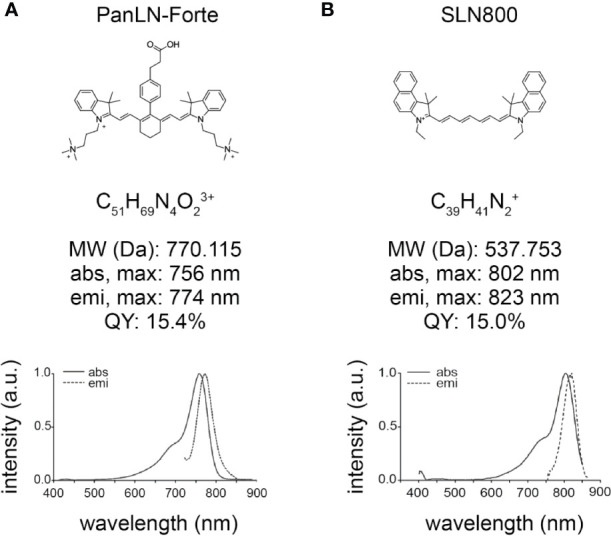
Chemical structure and optical properties of 800 nm lymph node fluorophores in HEPES-buffered serum, pH 7.4. (A) PanLN-Forte and (B) SLN800. abs, absorption; a.u., arbitrary units; Da, Dalton; emi, emission; max, maximum; MW, molecular weight; nm, nanometer; QY, quantum yield.